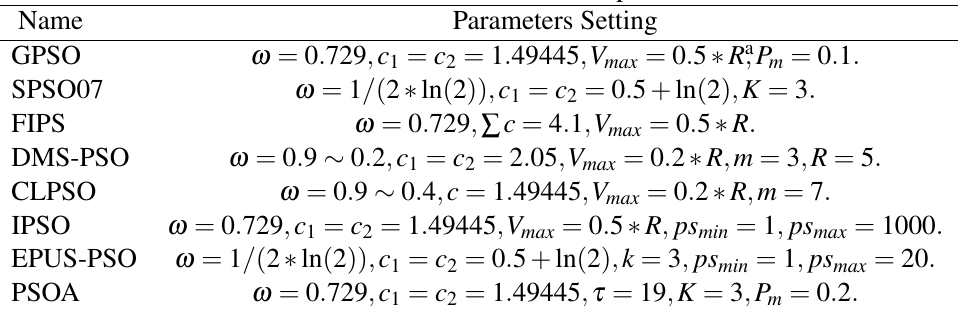
Table 3: Nine PSOs used for